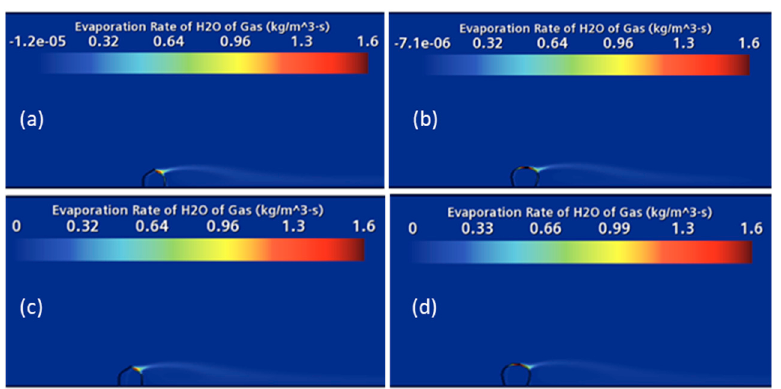
Figure 6. Evaporation Rate at different timings extrapolated from the CFD simulation. ( a ) Nero Spinoso at 0.5 s; ( b ) control (B73/Mo17 hybrid) at 0.5 s; ( c ) Nero Spinoso at 1 s; ( d ) control at 1 s.